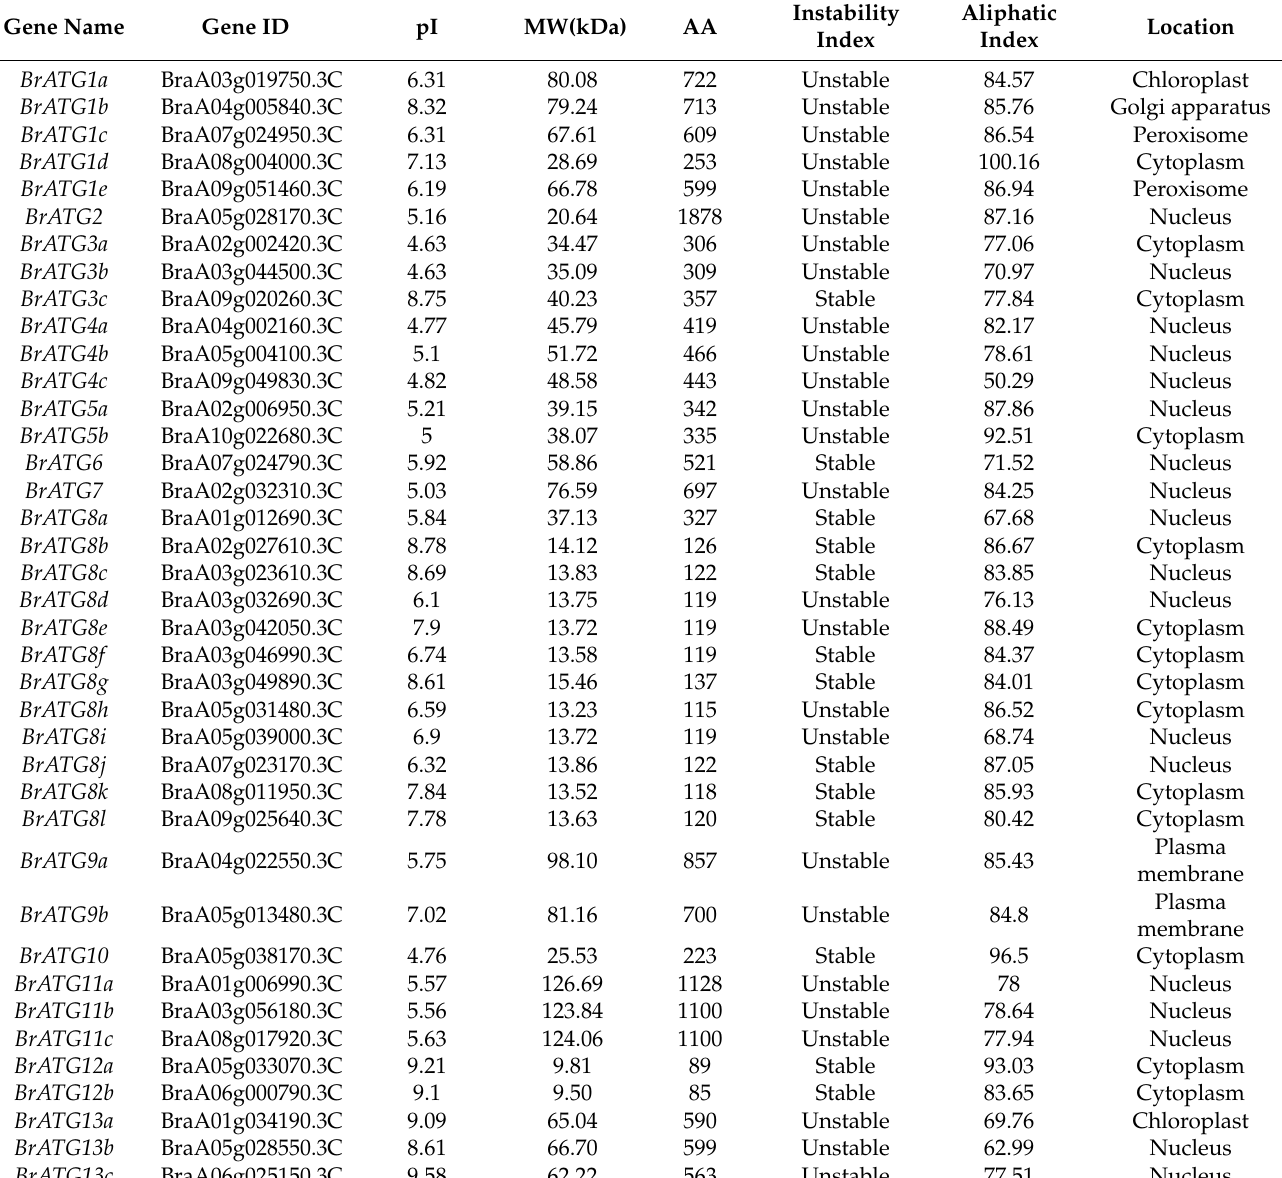
Table 1. Detailed information on autophagy-associated genes ( BrATGs ) in Chinese cabbage (pI: iso- electric point; MW: molecular weight; AA: amino acid